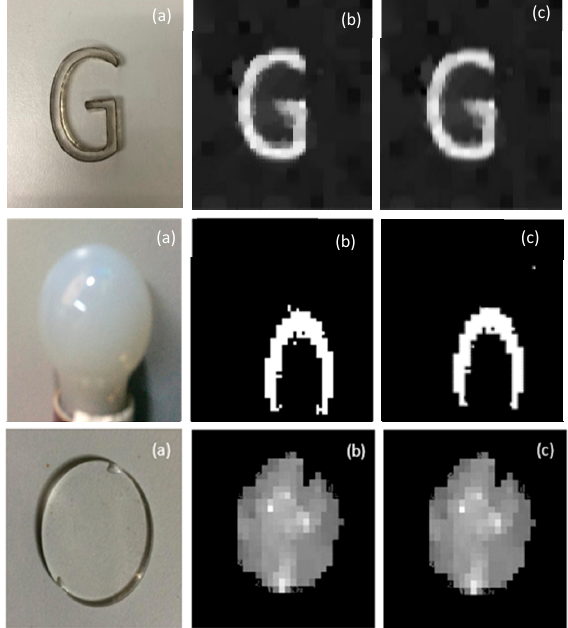
Figure 4. Two-dimensional image reconstruction results for the passive single-pixel imaging method. ( a ) The original object for reconstruction: “G” has a thickness of 10 mm, “bulb” has a size of 20 × 26 mm and “Transparent-circle” has a thickness of 5 mm. ( b ) The reconstructed 2D image from left and ( c ) right